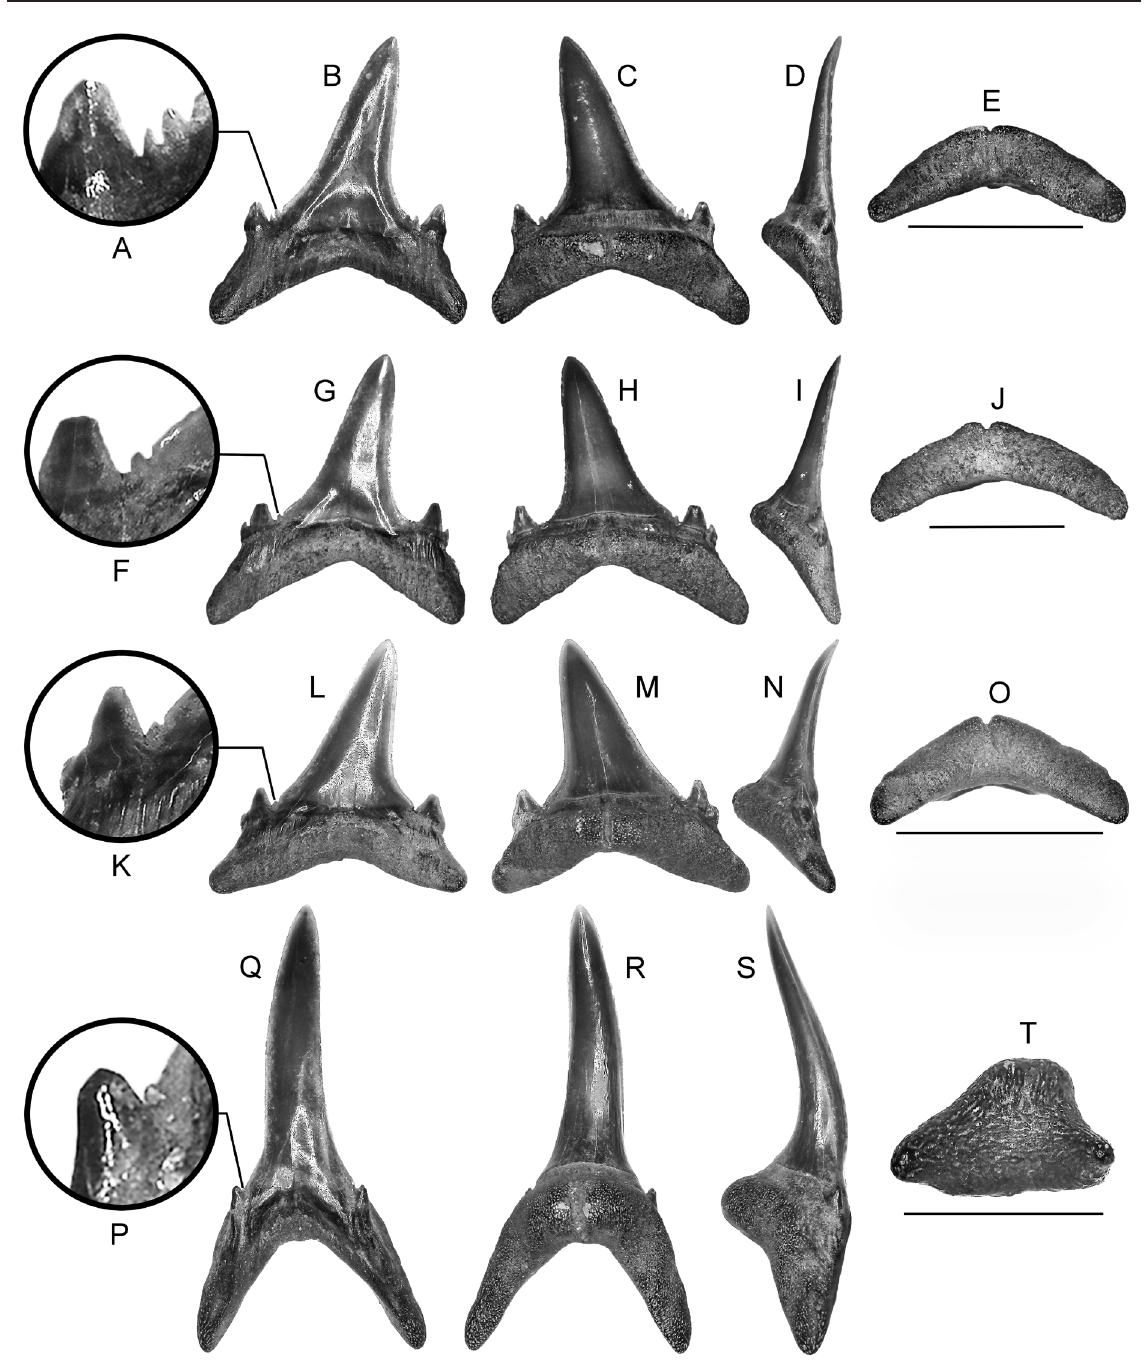
Fig. 17. Mennerotodus sp., teeth. A–E . ALMNH PV1994.4.16.1, upper right lateral tooth, Gosport Sand. A . Close-up of mesial denticulations. B . Labial view. C . Lingual view. D . Mesial view. E . Basal view. F–J . ALMNH PV1994.4.203.1, upper right lateral tooth, Gosport Sand. F . Close-up of mesial denticulation. G . Labial view. H . Lingual view. I . Mesial view. J . Basal view. K–O . ALMNH PV1989.4.17.3.8, upper left lateral tooth (reversed for comparison), Gosport Sand. K . Close-up of mesial denticulation. L . Labial view. M . Lingual view. N . Mesial view. O . Basal view. P–T . ALMNH PV1989.4.20, lower left second anterior tooth, Gosport Sand. P . Close-up of mesial denticulation. Q . Labial view. R . Lingual view. S . Mesial view. T . Basal view. Labial at bottom in basal views. Scale bars =